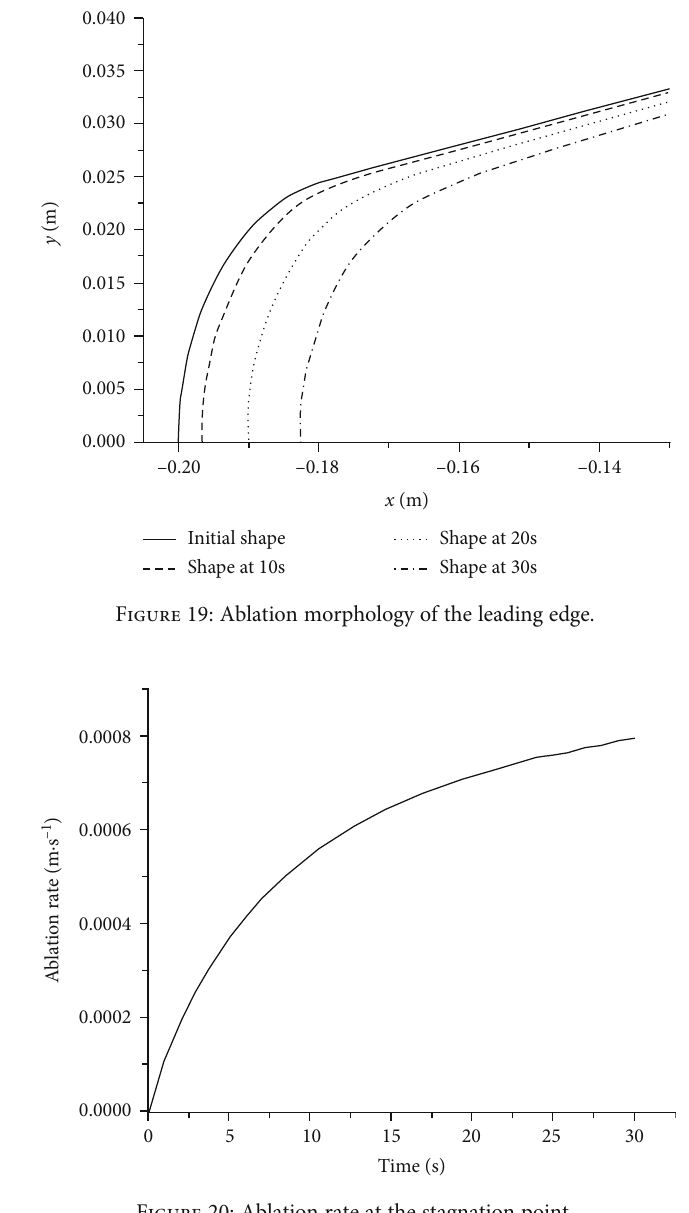
Figure 20: Ablation rate at the stagnation point.